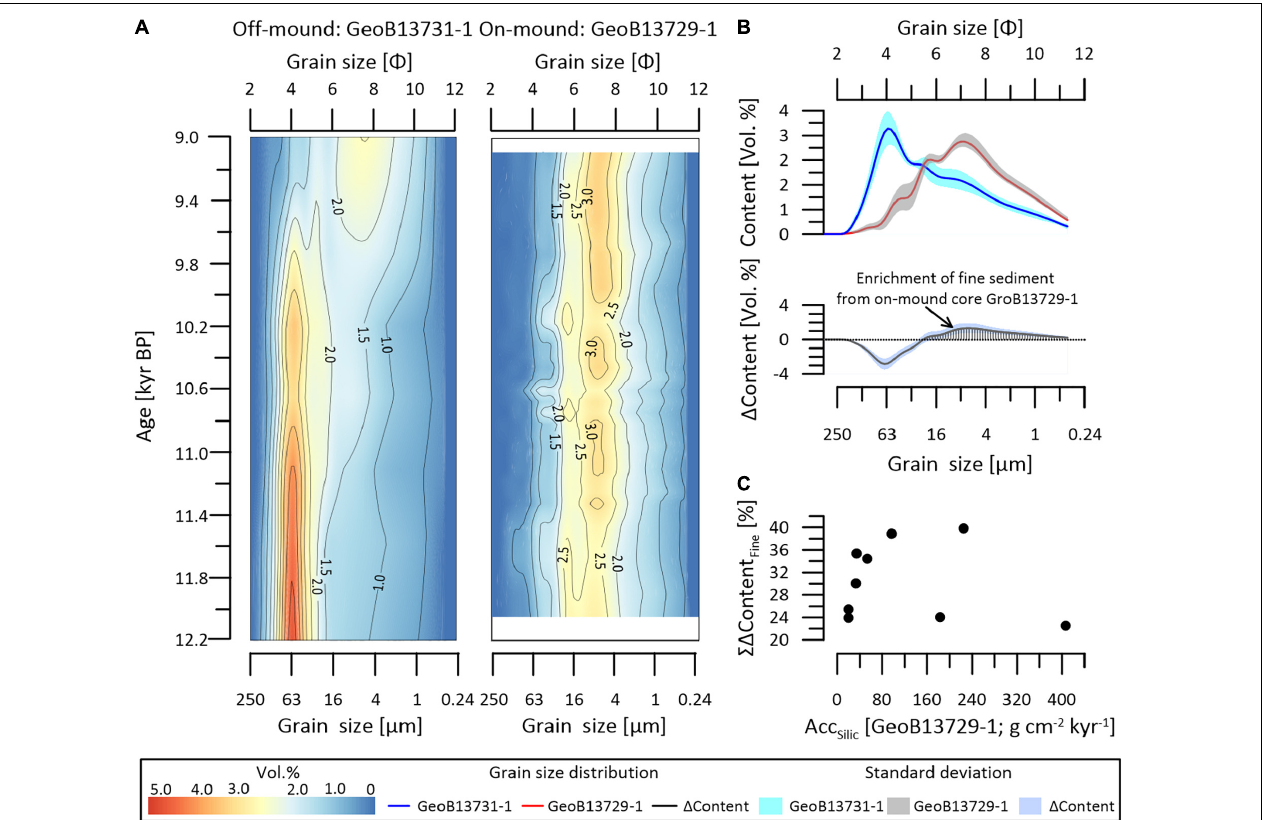
FIGURE 3 | (A) Grain-size distribution of the siliciclastic sediment fraction obtained from the off-mound core GeoB13731-1 and the on-mound core GeoB13729-1 for the mound formation period ( ∼ 12.1 to 9 kyr BP). (B) The averaged grain-size distribution of the two cores. The difference in grain-size distribution between the on- and the off-mound cores ( (cid:49) Content) was obtained by subtracting the off-mound core from the on-mound core grain-size distribution. The dashed area represents the averaged total enhancement of the siliciclastic fine fraction ( (cid:54)(cid:49) Content Fine ). (C) Scatter plot of the (cid:54)(cid:49) Content Fine versus accumulation rate of siliciclastic sediments (Acc Silic